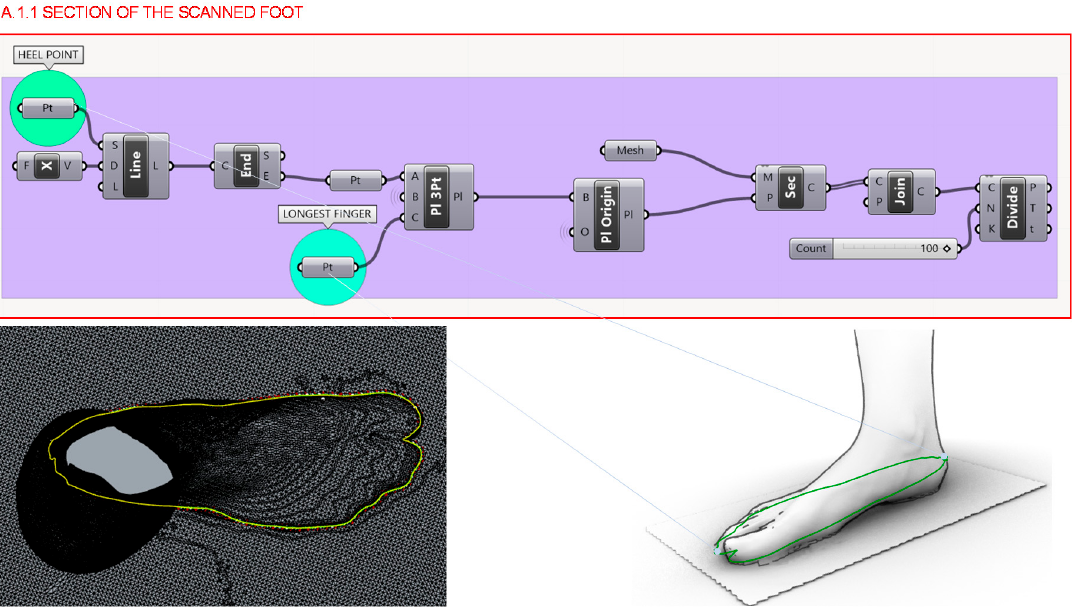
Figure 7. Programming structure definition to generate the sole of the last without gap.